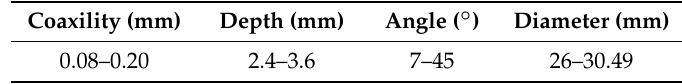
Table 4. The geometry parameters ranges of hollow head valve workpiece.